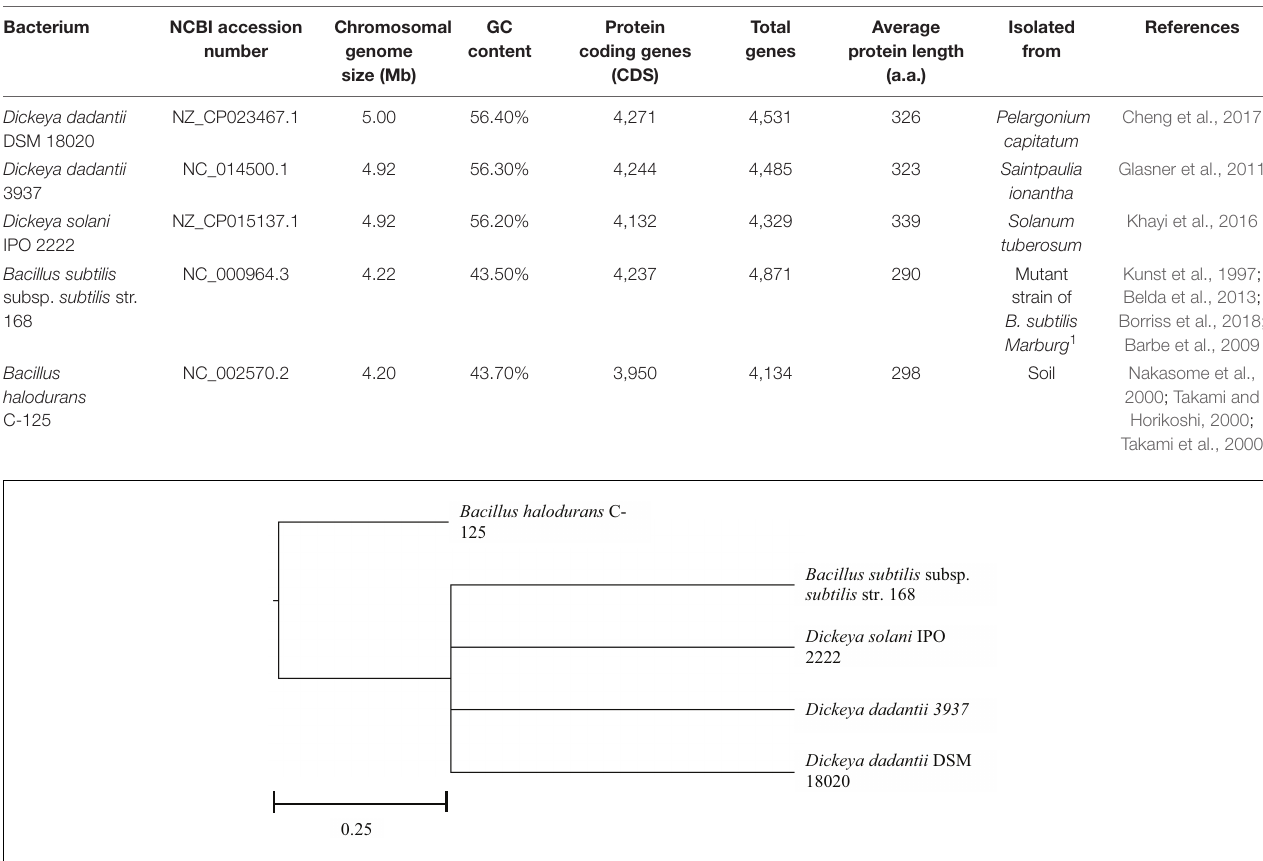
TABLE 1 | Comparative genomic information of five pectinase producing bacteria. Bacterium